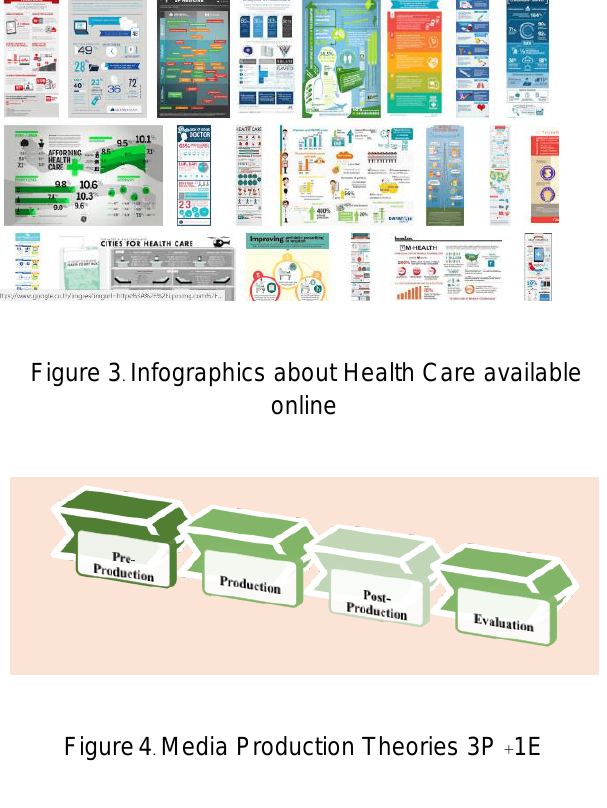
Table 1 . The 3P + 1E order and steps for AR application developing